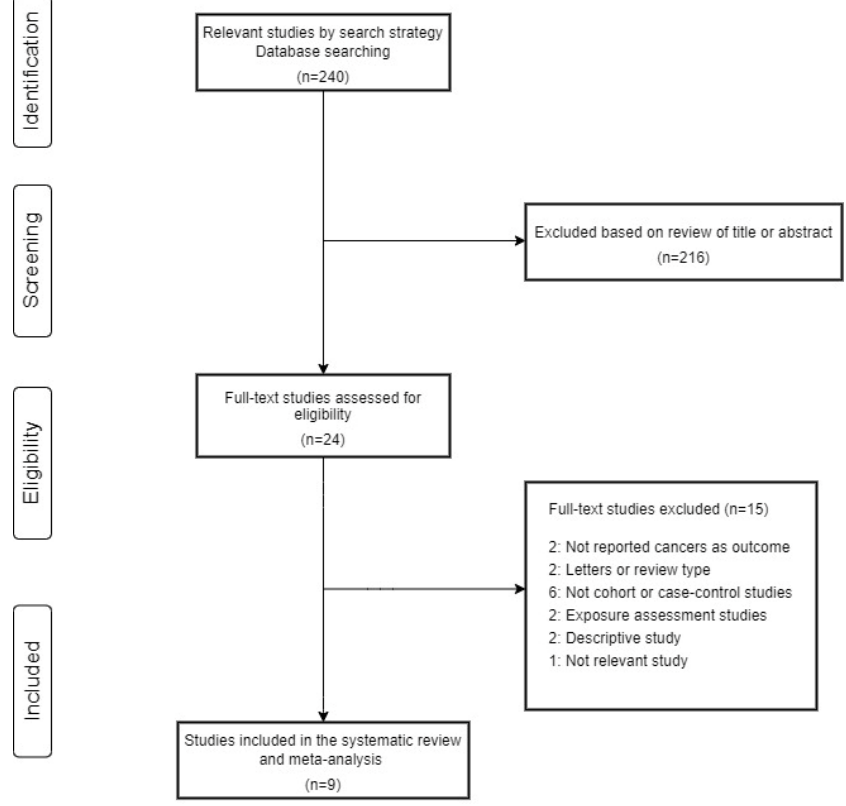
Figure 1. Study selection flow for systematic review and meta-analysis. Table 1. General characteristics of individual studies included in the